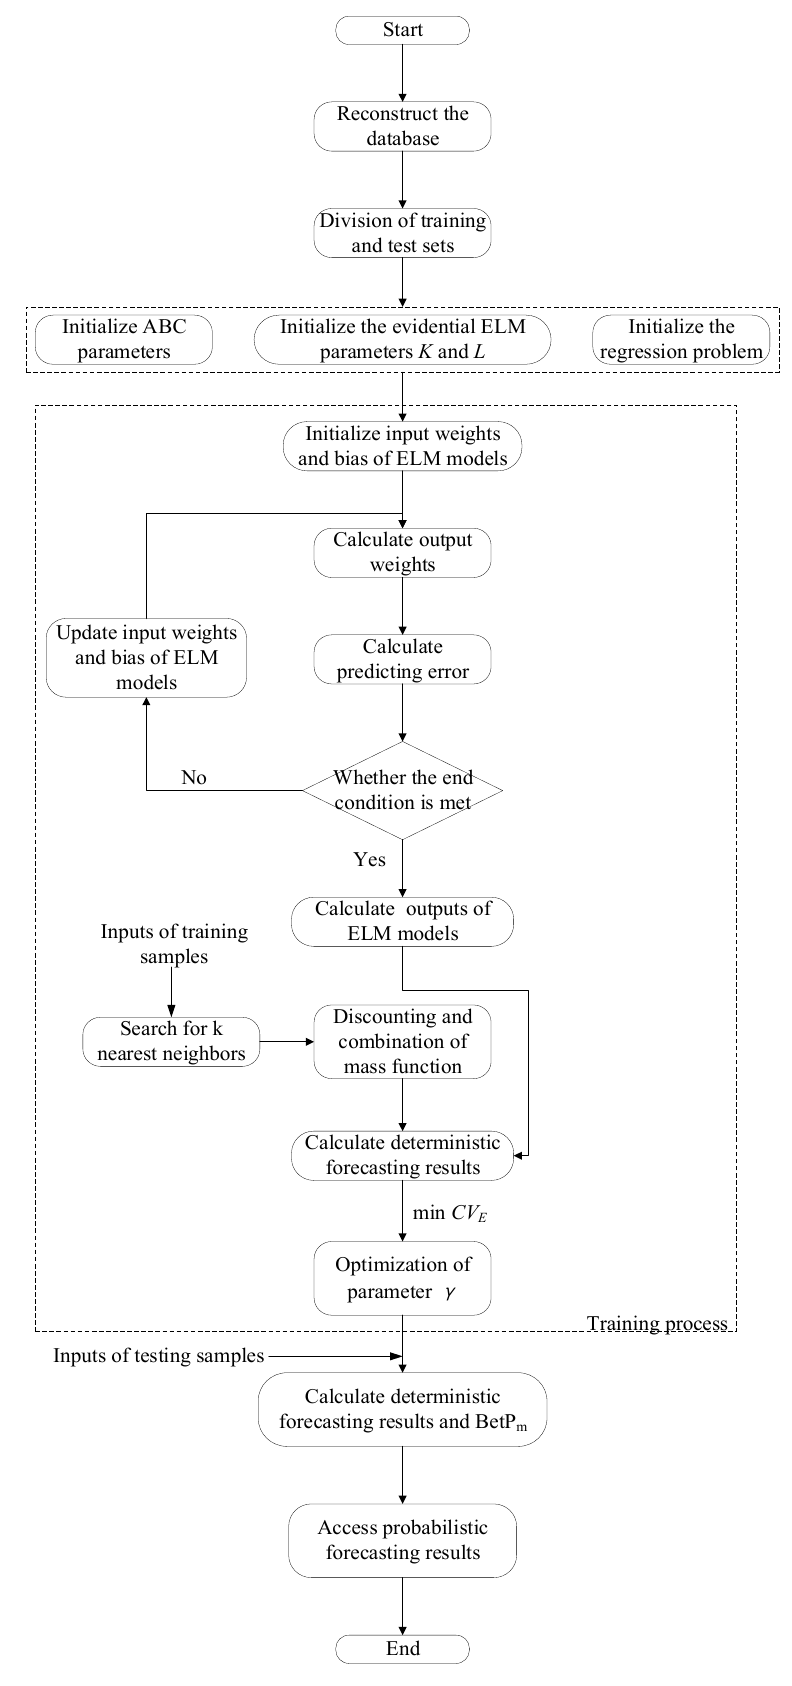
Figure 3. Algorithm process of EELM. Step 1. Initialize the regression problem and algorithm parameters.